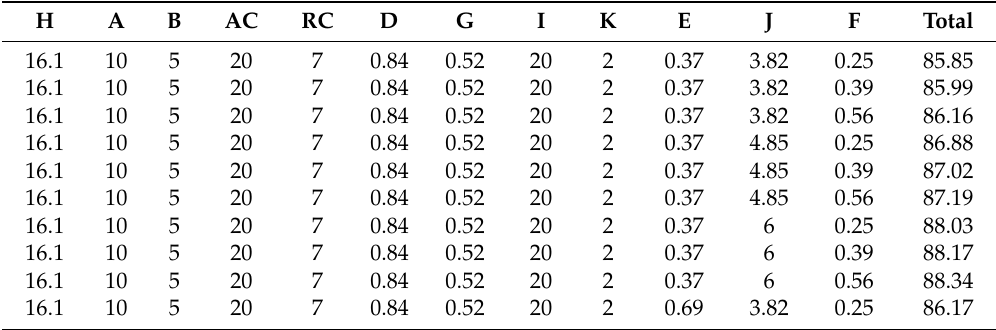
Table 5. Population count (in percentage/100 g).